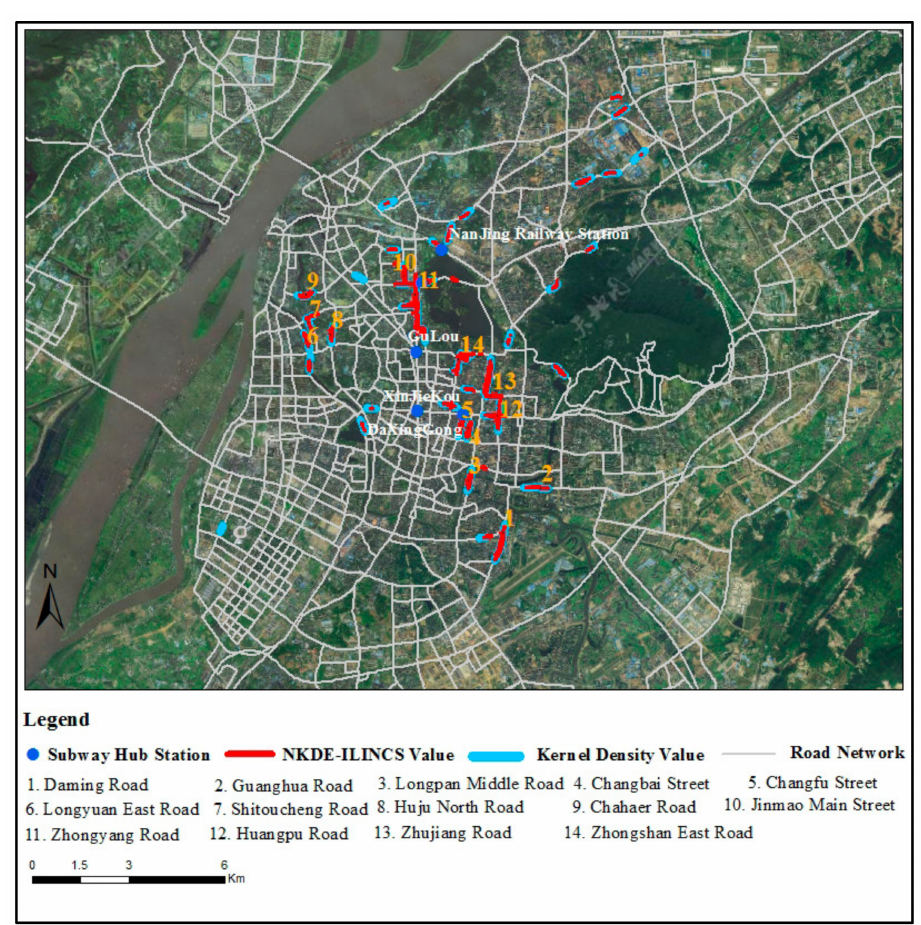
Figure 17. The higher-risk locations under road network space in urban